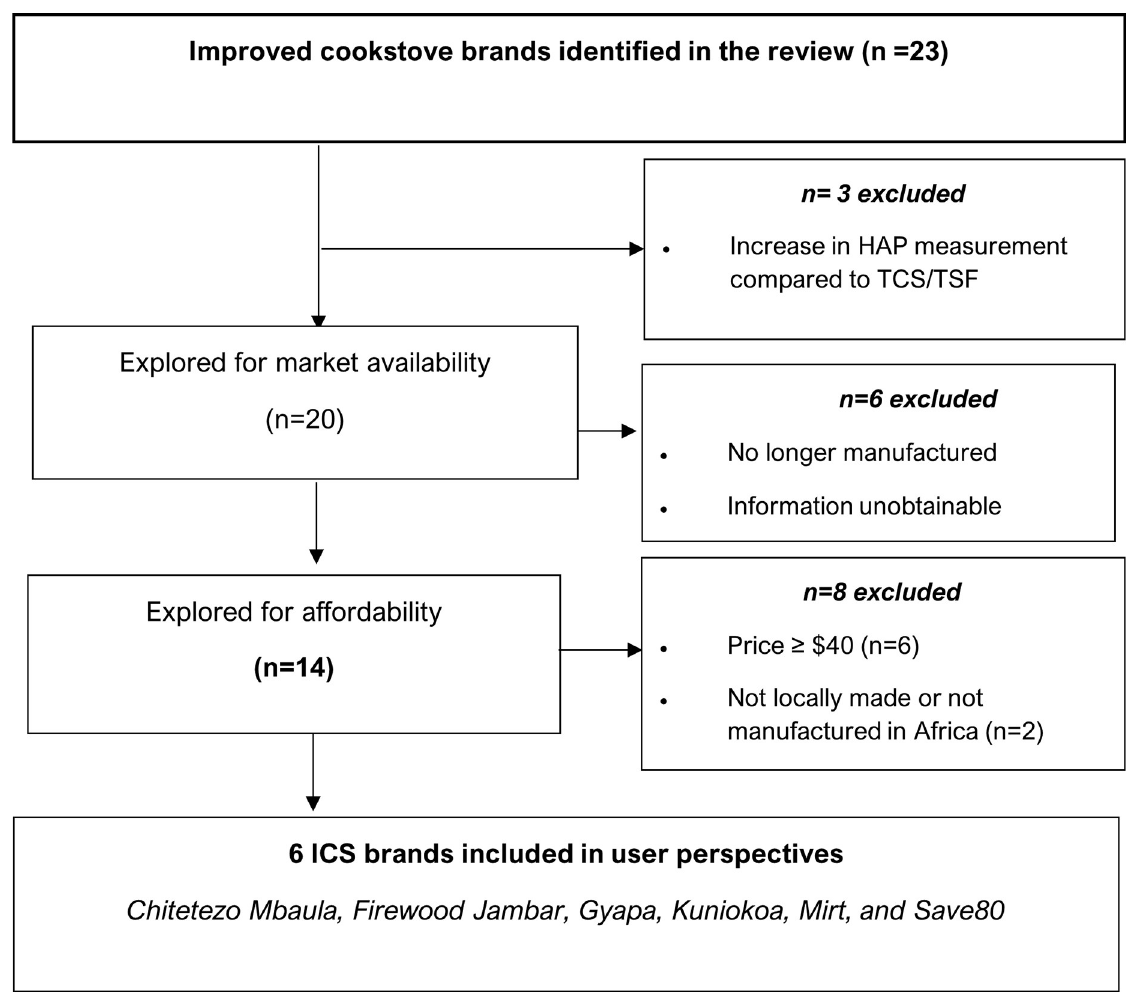
Fig 5. Systematic selection of ICS for effectiveness in HAP reduction, market availability, and